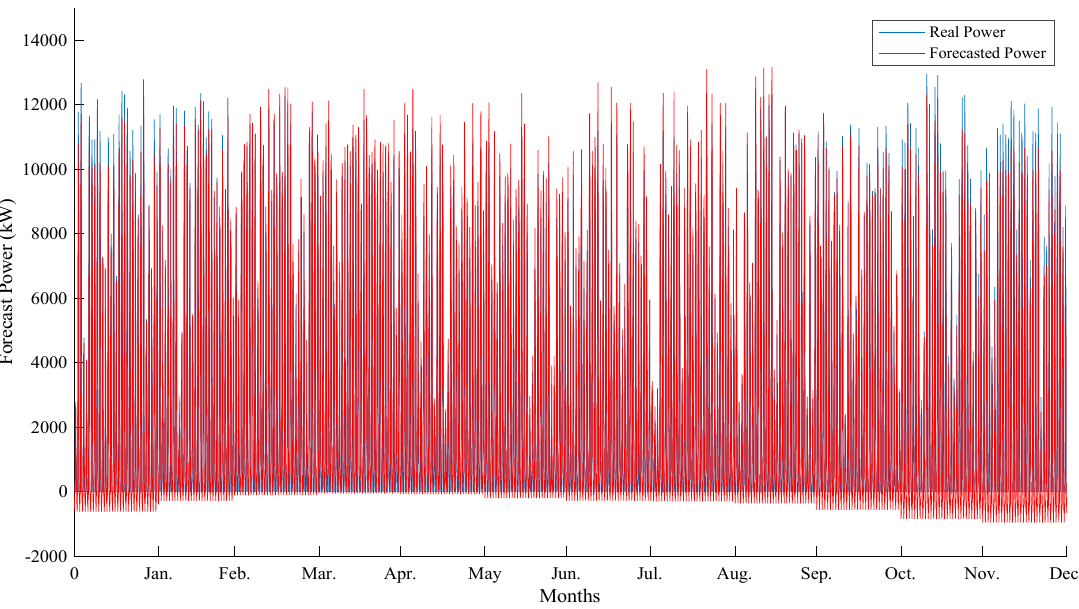
Figure 11. Annual PV power output with PSO-ANN forecasting.